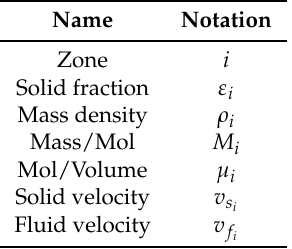
Table 1. Notation used in the model, where ρ i = M i µ i , ω α = µ 0 / µ 1 and ω β = µ 1 / µ 2